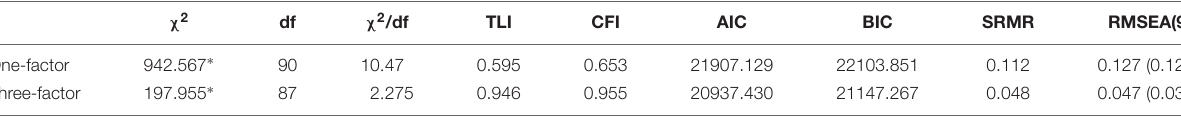
TABLE 4 | Fitting indices of models ( n = 585).